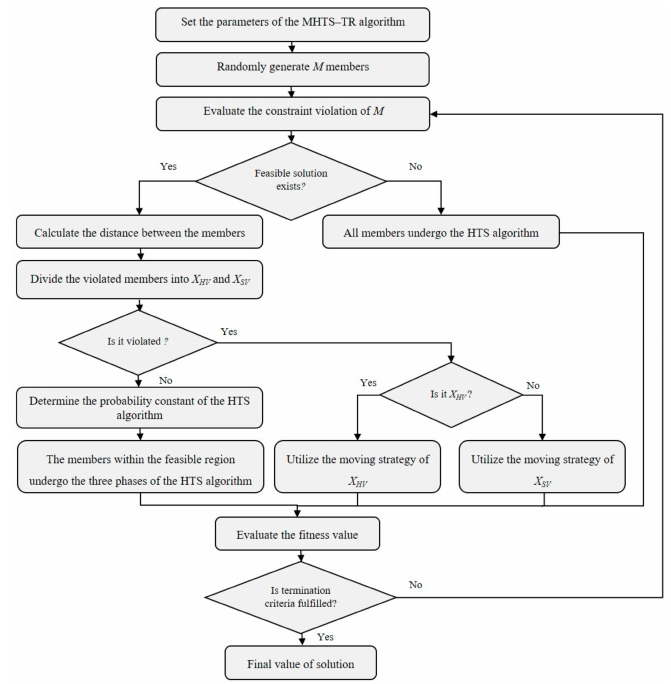
Figure 4. Flowchart of the MHTS–TR